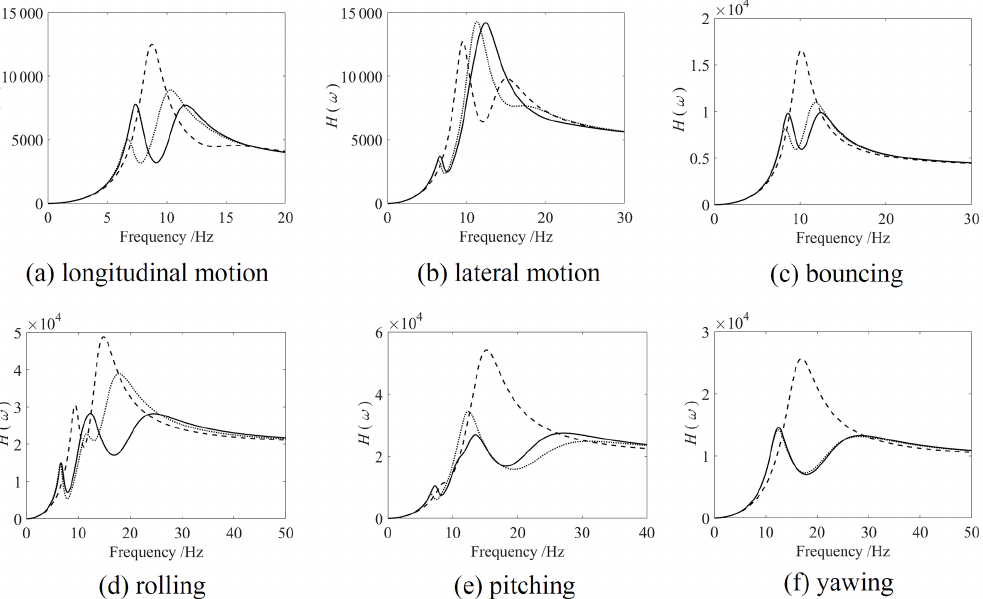
Figure 3. Acceleration FRF of the main system. Dashed line: without MDOF DVA; dotted line: with original MDOF DVA; solid line: with optimized MDOF